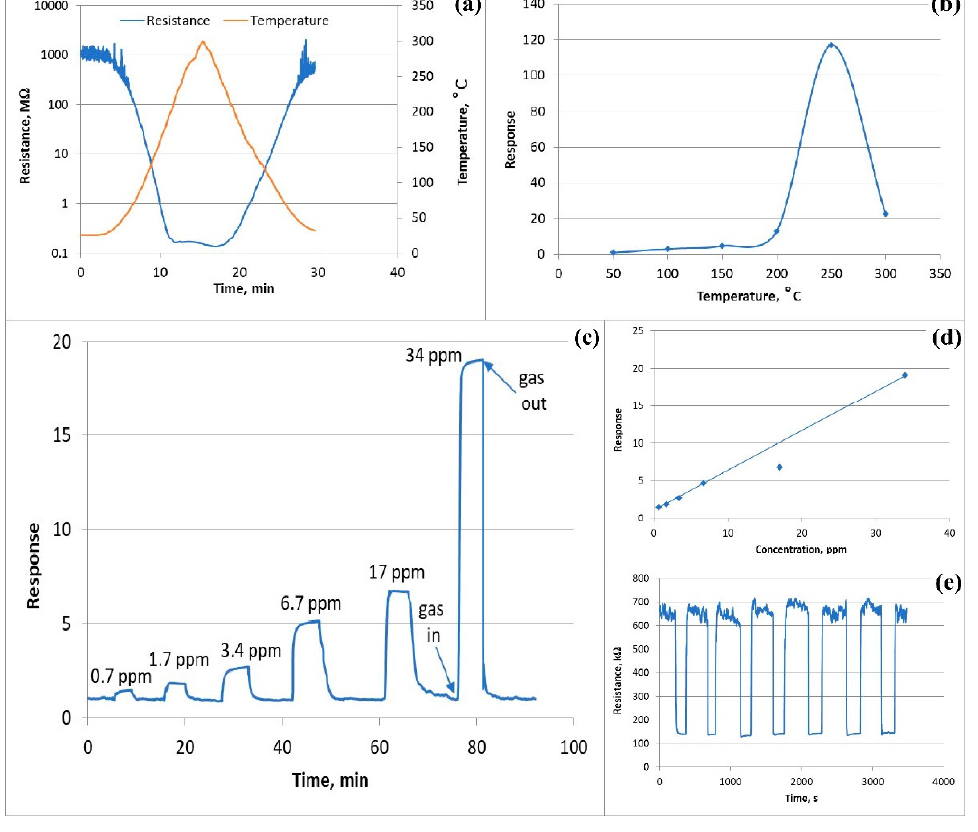
Figure 10. ( a ) Change in sensor resistance depending on the operating temperature in air, ( b ) response of the sensor to 675 ppm ethanol vapor in different temperatures, ( c ) dynamic response curves of the ZnO<La> sensor to different concentrations of ethanol at operating temperature, ( d ) ethanol concentration vs. sensor response, and ( e ) repeatability test of the sensor during seven cycles to 6.7 ppm ethanol. Table 1. Gas sensing parameters of the ZnO<La> sensor at different temperatures in the presence of 675 ppm of ethanol